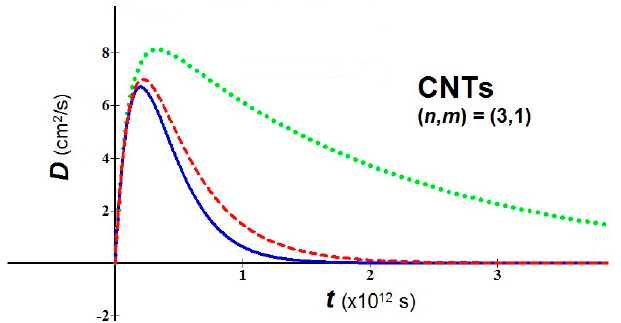
= 0.5 = red dashed line; I